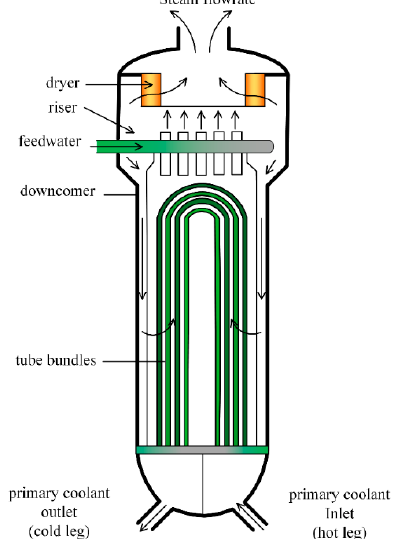
Figure 1. Structure of the U-type SG. SG is a highly complex, nonlinear, and time-varying inverse dynamic system. Swell and shrink are one of an SG’s dynamic characteristics. The level of SG is influenced by flow. However, at the same time, it is also affected by the feedwater temperature, the pressure in the SG, the number of bubbles, and other factors, and the level characteristics under different powers are also quite